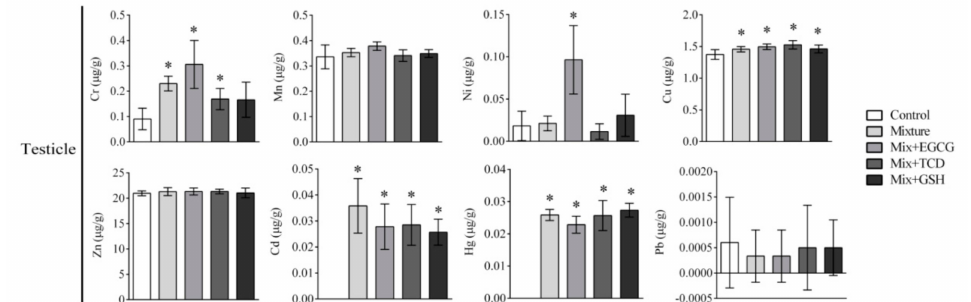
Figure 6. Contents of eight heavy metals in the testicle of SD rats. Bars represented contents of eight heavy metals (ug) in per gram of organs; n = 6 rats / each group; Results were presented as means ± SD; One-way ANOVA and LSD-t test were used. * p < 0.05, vs. the control group (Mixture, Mix + EGCG, Mix + TCD, Mix + GSH compared with the control group); Mix,